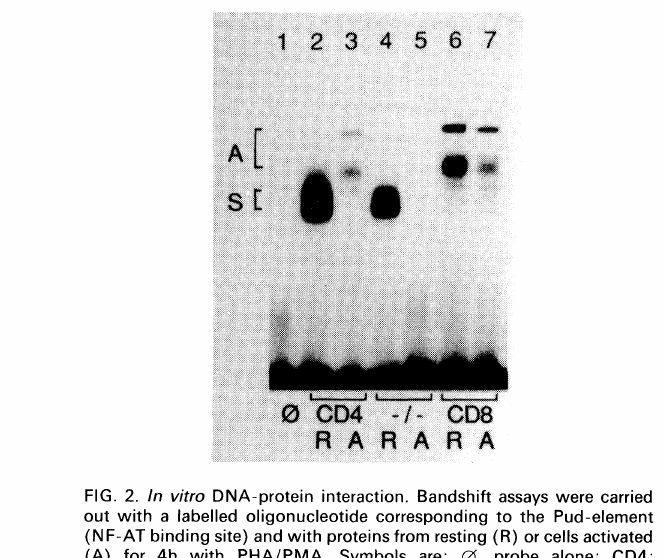
FIG. 2. In vitro DNA-protein interaction. Bandshift assays were carried out with a labelled oligonucleotide corresponding to the Pud-element , (NF-AT binding site) and with proteins from resting (R) or cells activated (A) for 4h with PHA/PMA. Symbols are: probe alone; CD4: CD4+CD8-; CD8: CD8+CD4-; -/-: CD4-CD8- cells. A, left to the panel, indicates the retarded complexes formed by putative positive TFs, S, with silencer proteins.